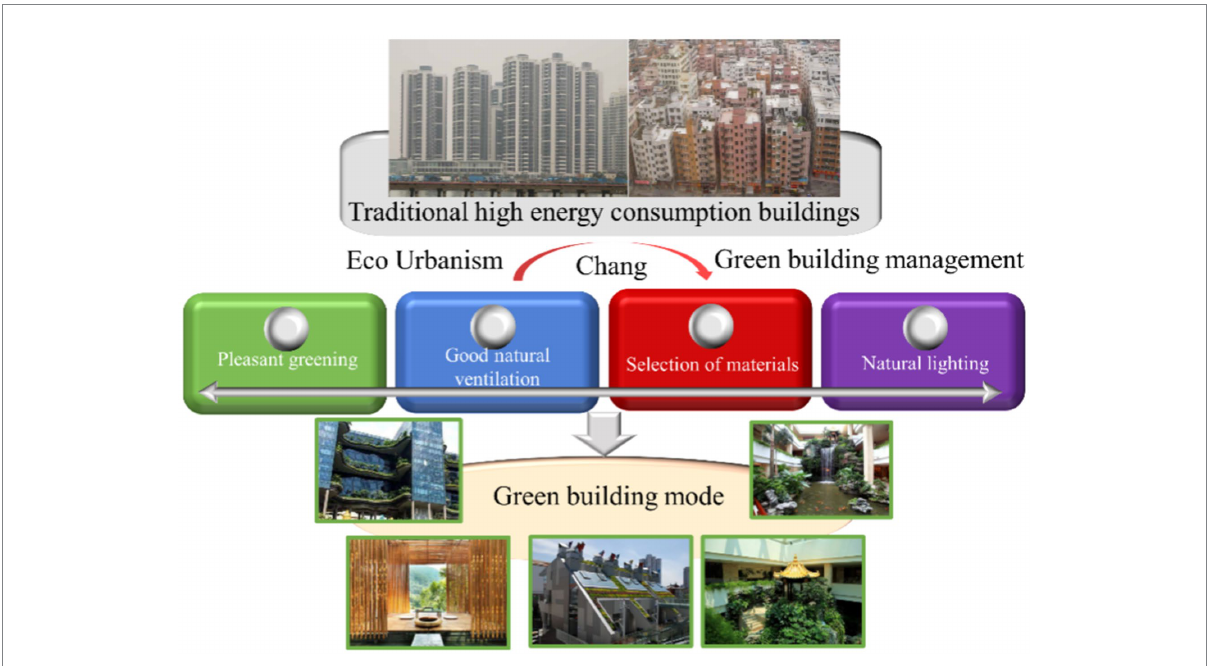
FIGURE 1 Schematic diagram of green building management system based on Eco urbanism.